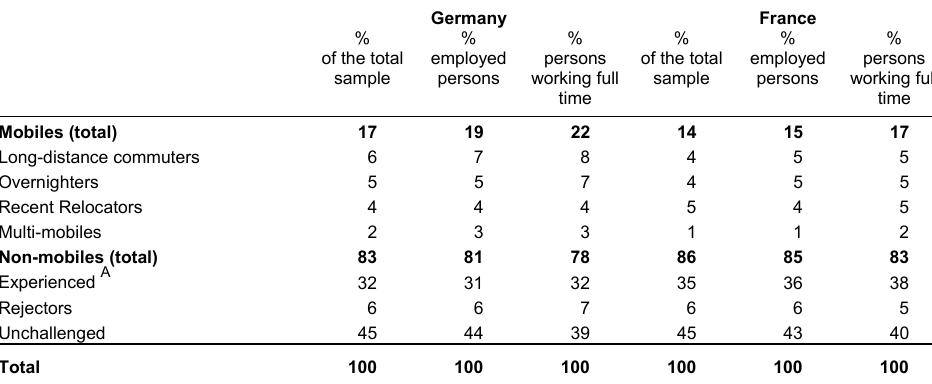
Table 1 : Types of mobility in Germany and in France according to the employment situation